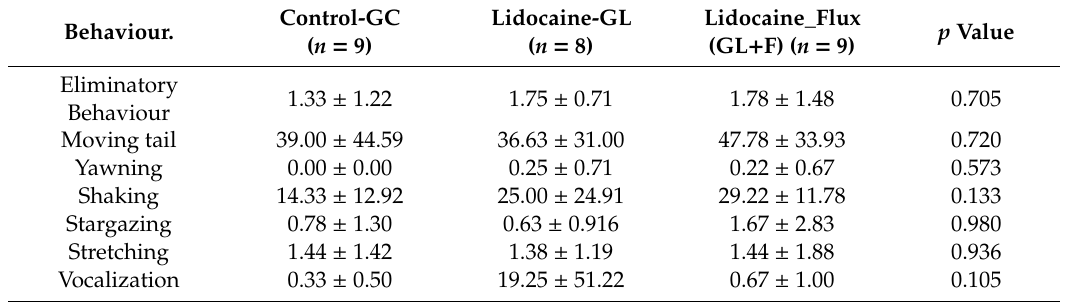
Table 5. Average number ( ± SD) of manifestation of each event for each group during the observation period and respective p